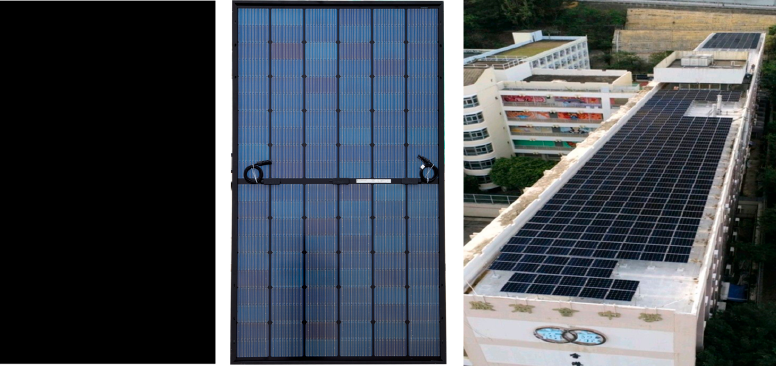
Figure 11. Pictures of bifacial ZEBRA module (ANDROMEDA2.0 by SPIC) from the front and back ( left ) and application in Hong Kong on a flat roof ( right ).